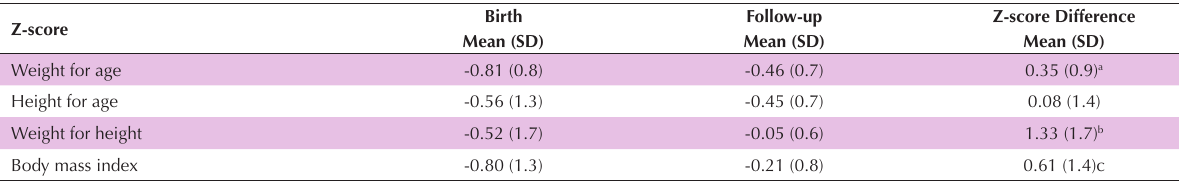
Table 3. Z-score of anthropometric indexes birth – follow up and Z-score difference